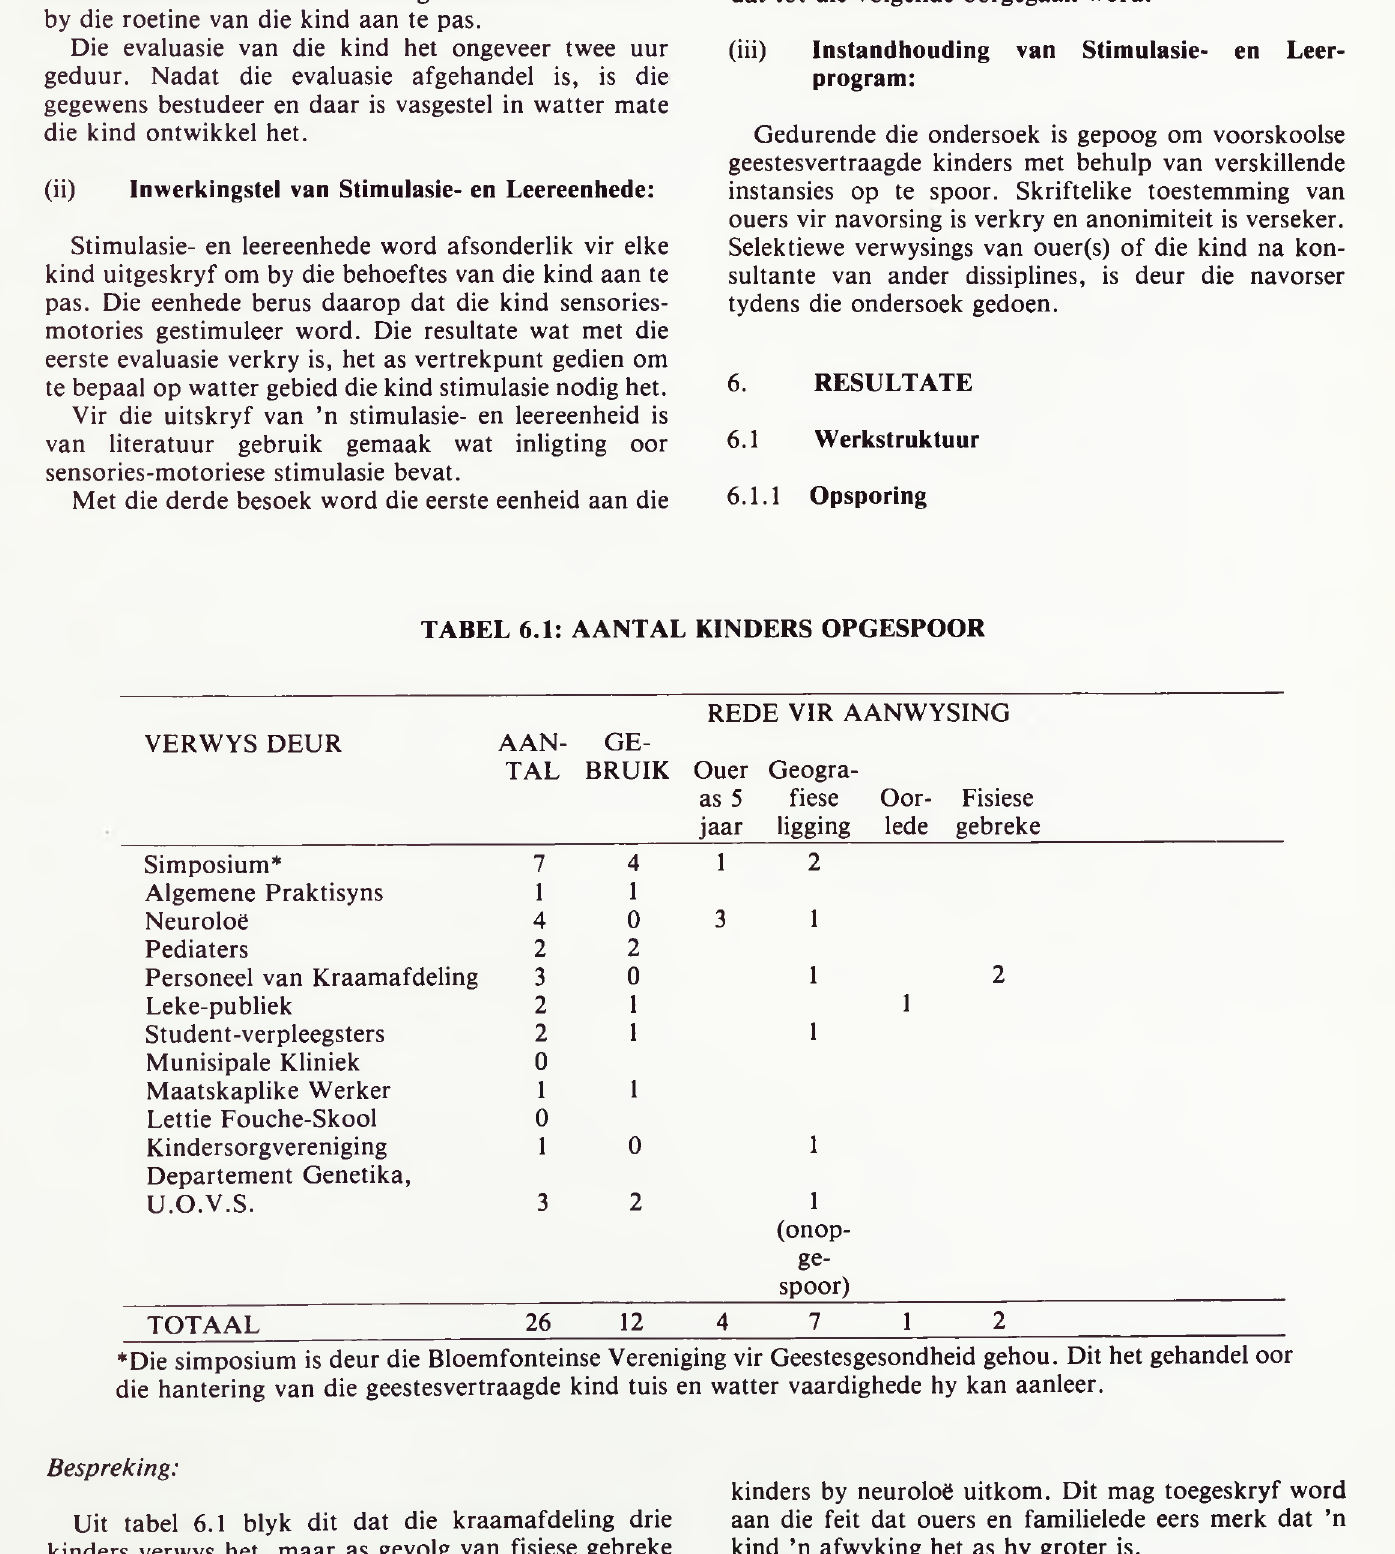
Tabel 6.1 toon dat die neiging bestaan dat